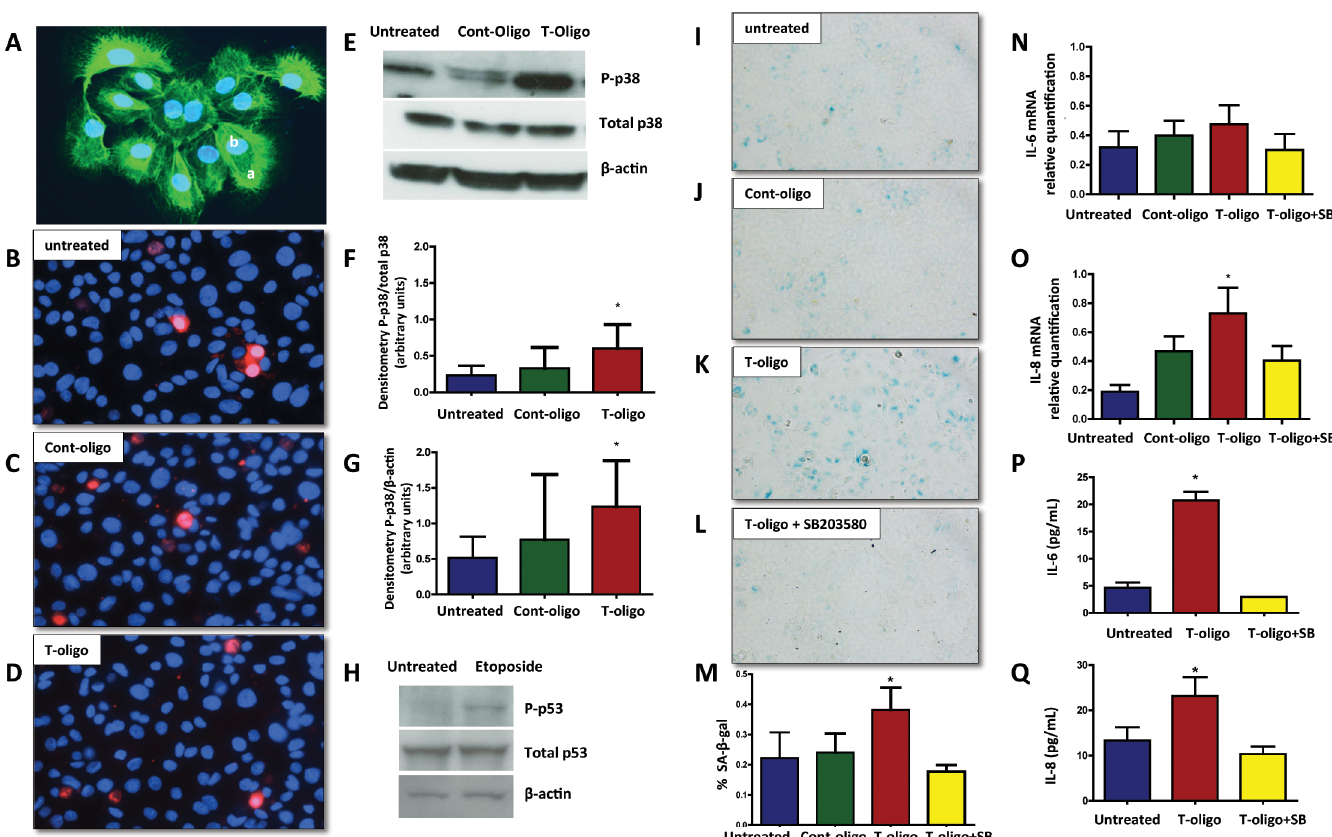
Fig 2. Human amniotic cells primary cultures. (A) Immunofluorescent staining of cytokeratin positive amnion epithelial cells. Inset, a. cytokeratin positive cells and b. nuclear staining DAPI. Original magnification x40. (B-D) Cell viability. Representative fluorescence photomicrographs of merged propidium iodide and Hoechst 33342-stained amnion cells. B. Untreated cells, C. Cont-oligo treated cells and D. T-oligo treated cells. Original magnification x40. (E-G) Representative image of Western blot analysis and densitometric quantitation of p38MAPK activation in amnion cells. E. Top panel = phosphorylated (P)- p38MAPK, middle panel = total p38MAPK and bottom panel = β -actin in untreated, Cont-oligo and T-oligo treated cells, respectively. F. Quantitation of P- p38MAPK densitometry normalized to total p38MAPK. T-oligo treatment produced significant ( * ) increase in P-p38MAPK compared to both untreated and Cont-oligo treated cells. G. Densitometric quantitation of P-p38MAPK normalized to β -actin. Post hoc tests indicated that T-oligo treatment produced significant ( * ) increase in P-p38MAPK compared to untreated control, but was not significant compared to Cont-oligo treatment. ( * ANOVA, p < 0.05). (H) Representative image of Western blot analysis of p53 activation in human amnion cells. Top panel = P-p53, middle panel = total p53 and bottom panel = β - actin in untreated and etoposide treated amnion cells, respectively. (I-M) Senescence associated β -galactosidase (SA- β -gal) staining of amnion cells. Single blue stained cells indicate positive β -gal activity. I. Untreated cells, J. Cont-oligo treated cells, K. T-oligo treated cells and L. T-oligo+SB203580 (p38MAPK inhibitor) treated cells. M. Quantification of the positive SA- β -gal cells. Bar graphs represent the differences in the percentage of SA- β -gal staining cells in each group. T-oligo treatment produced a significant increase ( * ) in the number of senescing cells, which was inhibited by SB203580 treatment. ( * ANOVA, p < 0.001). (N-Q) Senescence associated sterile inflammation in amnion cells. N. Relative quantification of IL-6 mRNA (p > 0.05), O. Relative quantification of IL-8 mRNA in amnion cells ( * p = 0.02), P. Protein concentration of IL-6 in conditioned media ( * p < 0.0001), and Q. Protein concentration of IL-8 in conditioned media ( * p = 0.001). The production of IL-8 and IL-6 was inhibited by simultaneous treatment with SB203580. * ANOVA, T-oligo treated samples significantly higher compared with untreated, cont-oligo or T-oligo+SB samples. (Results are representative from 5 amnion cultures/ group. Telomere mimetic overhang sequence (T-oligo, [TTAGGG] 2 ); control oligonucleotides (Cont-oligo, [AATCCC] 2 ); untreated cells (Control